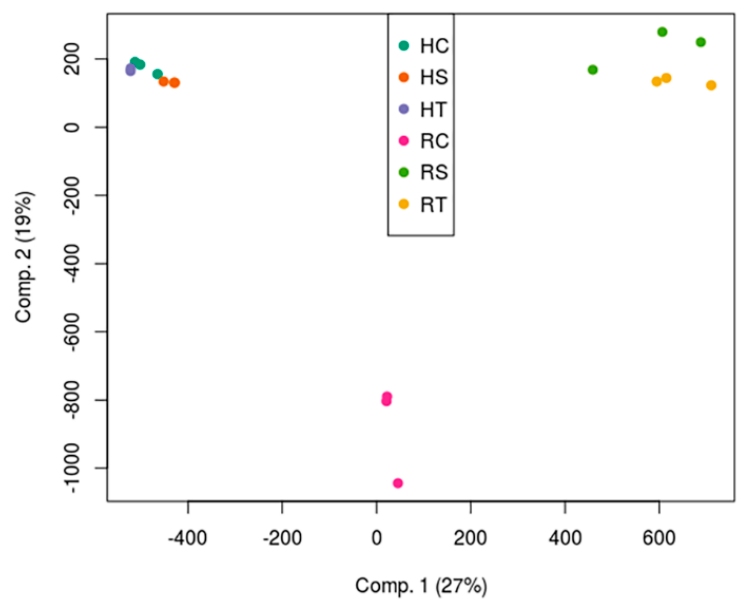
Figure 4. Principal component analysis of the transcriptomes of the samples. HC, HS, and HT refer to control leaves, sensitive leaves, and tolerant leaves, respectively. RC, RS, and RT refer to control roots, sensitive roots, and tolerant roots, respectively.